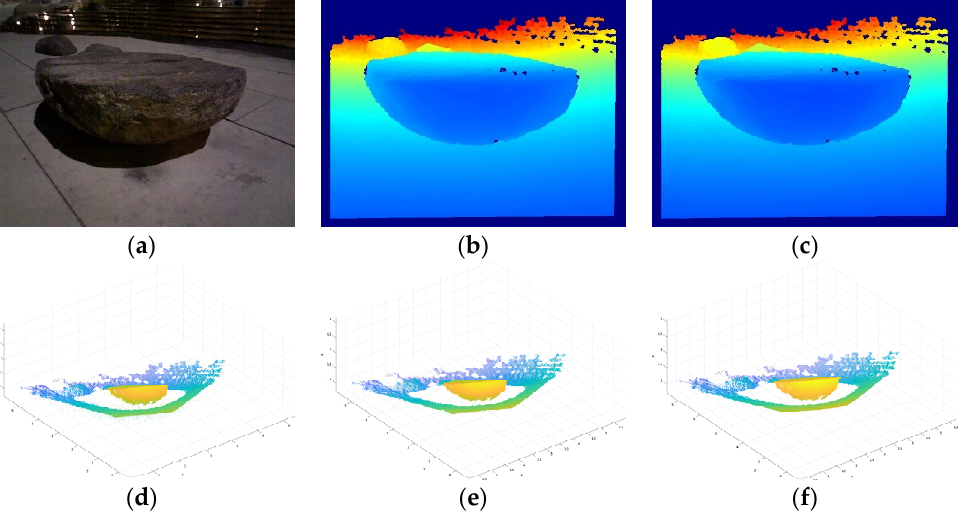
Figure 10. Denoising effects of fractional integral denoising and median filtering. ( a ) RGB image (dataset number 03236); ( b ) deep pseudo-colour map (dataset number 03236); ( c ) no noise point cloud image added; ( d ) point cloud image with added noise, PSNR = 47.599 dB; ( e ) point cloud image filtered by the fractional integral denoising ( ν = − 0.3, PSNR = 52.070 dB); ( f ) point cloud of the depth image after median filtering and denoising (PSNR = 36.107 dB).